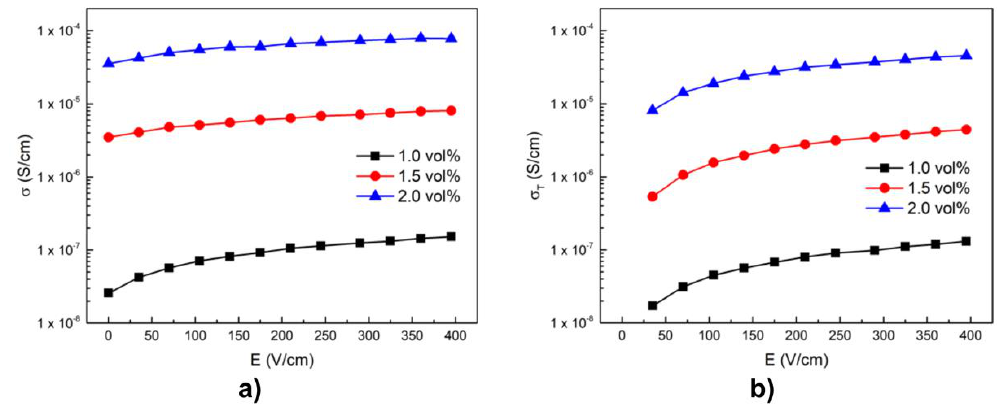
Figure 23. ( a ) 𝜎 and ( b ) 𝜎 𝑇 as a function of electrical field for CNF/HDPE composites of vari- Figure 23. ( a ) σ and ( b ) σ T as a function of electrical field for CNF/HDPE composites of various filler concentrations at ous filler concentrations at room temperature. Data extracted from Ref. [68]. room temperature. Data extracted from Ref.